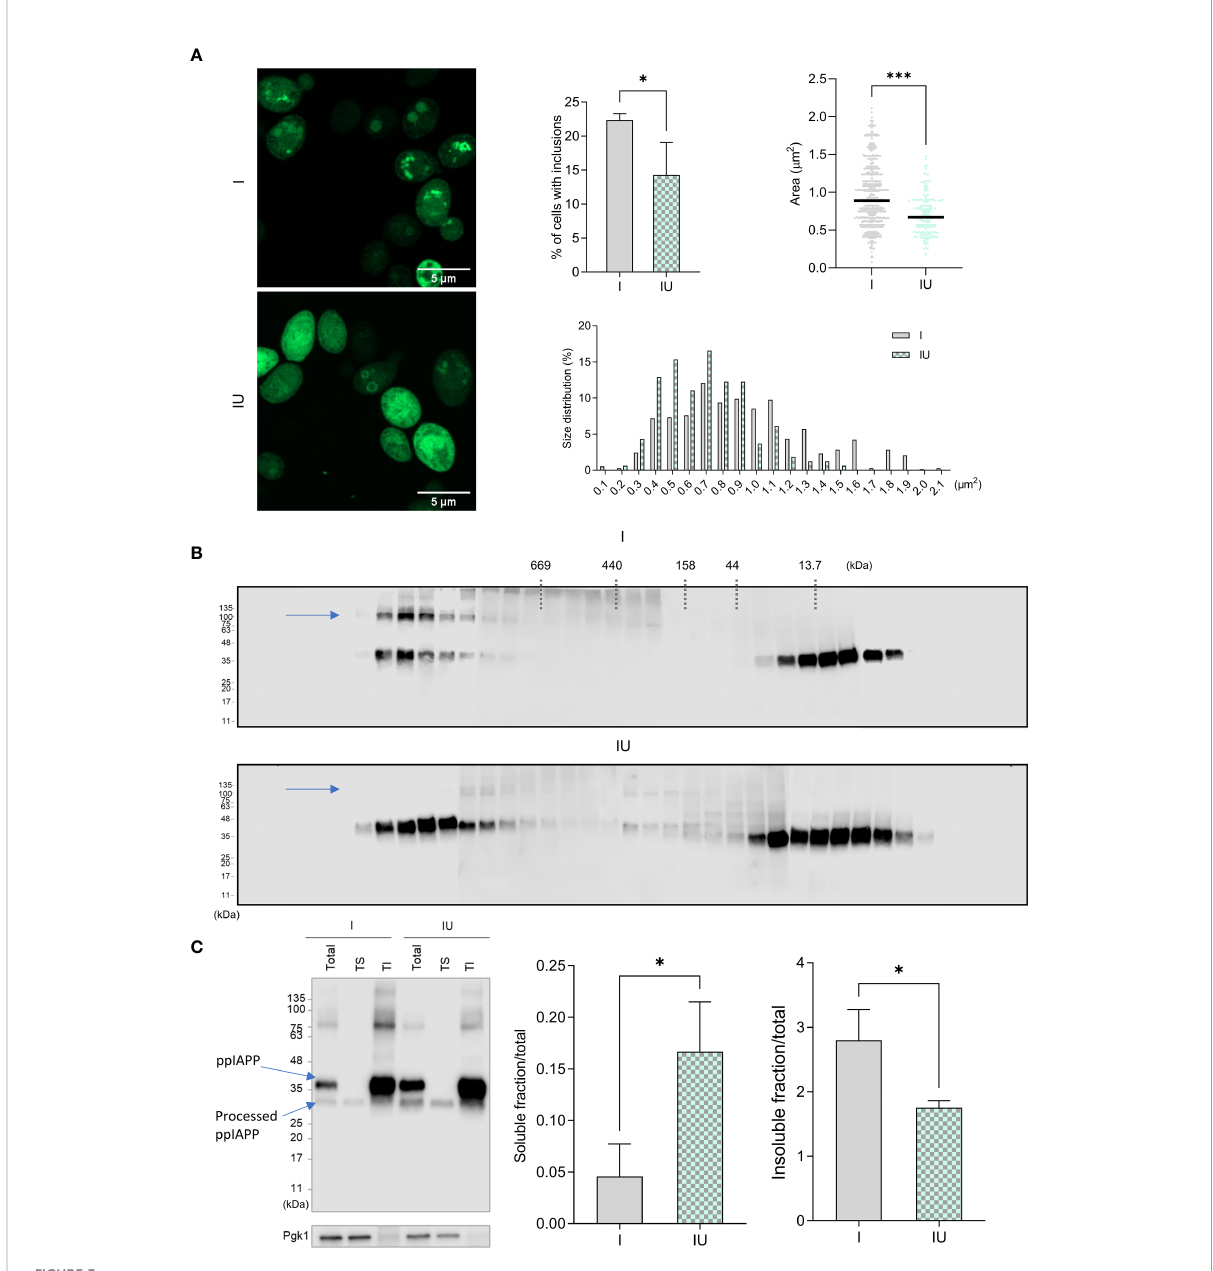
FIGURE 3 Urolithin B changes the size and the chemical properties of IAPP aggregates in a cellular milieu. (A) Confocal microscopy of yeast cells expressing ppIAPP in the presence or absence of 50 µM urolithin B (UroB) indicating the number of cells with inclusions (upper left panel), the area of the inclusions (upper right panel), and their distribution in size (lower panel). (B) Size Exclusion Chromatography of protein extracts from cells expressing ppIAPP with or without 50 µM urolithin (C) Separation of protein extract according to their solubility in Triton X-100. The values represent mean ± SD from at least three independent experiments. Statistical differences are denoted as * p < 0.05 vs. the control condition. I, cells expressing ppIAPP; IU, cells expressing ppIAPP incubated with UroB. TS, Triton soluble fraction. TI, Triton insoluble fraction. Pgk1, Phosphoglycerate kinase 1. Representative images are shown. Statistical differences are denoted as *p < 0.05, ***p < 0.001 vs. the control